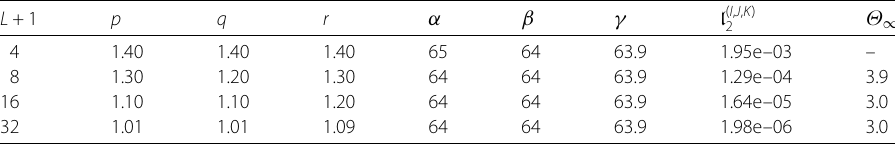
Table 2d Errors and computational rate for the EF-EEG-TOCS in Example